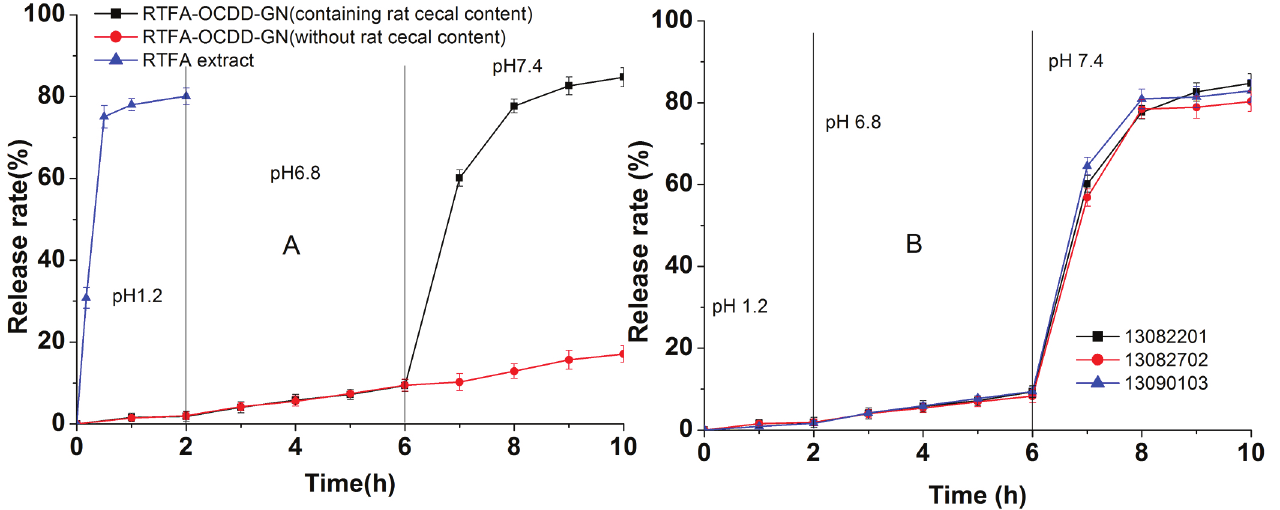
FIGURE 5 - The dissolution profiles of the core drug-load granules in pH 1.2 and RTFA-OCDD-GN in a simulated gastric fluid (pH 1.2) and a simulated small-intestinal fluid (pH 6.8) and a simulated colonic fluid (pH 7.4) in the presence or absence of rat cecal contents (A), and the dissolution test reproducibility of three batches RTFA-OCDD-GN